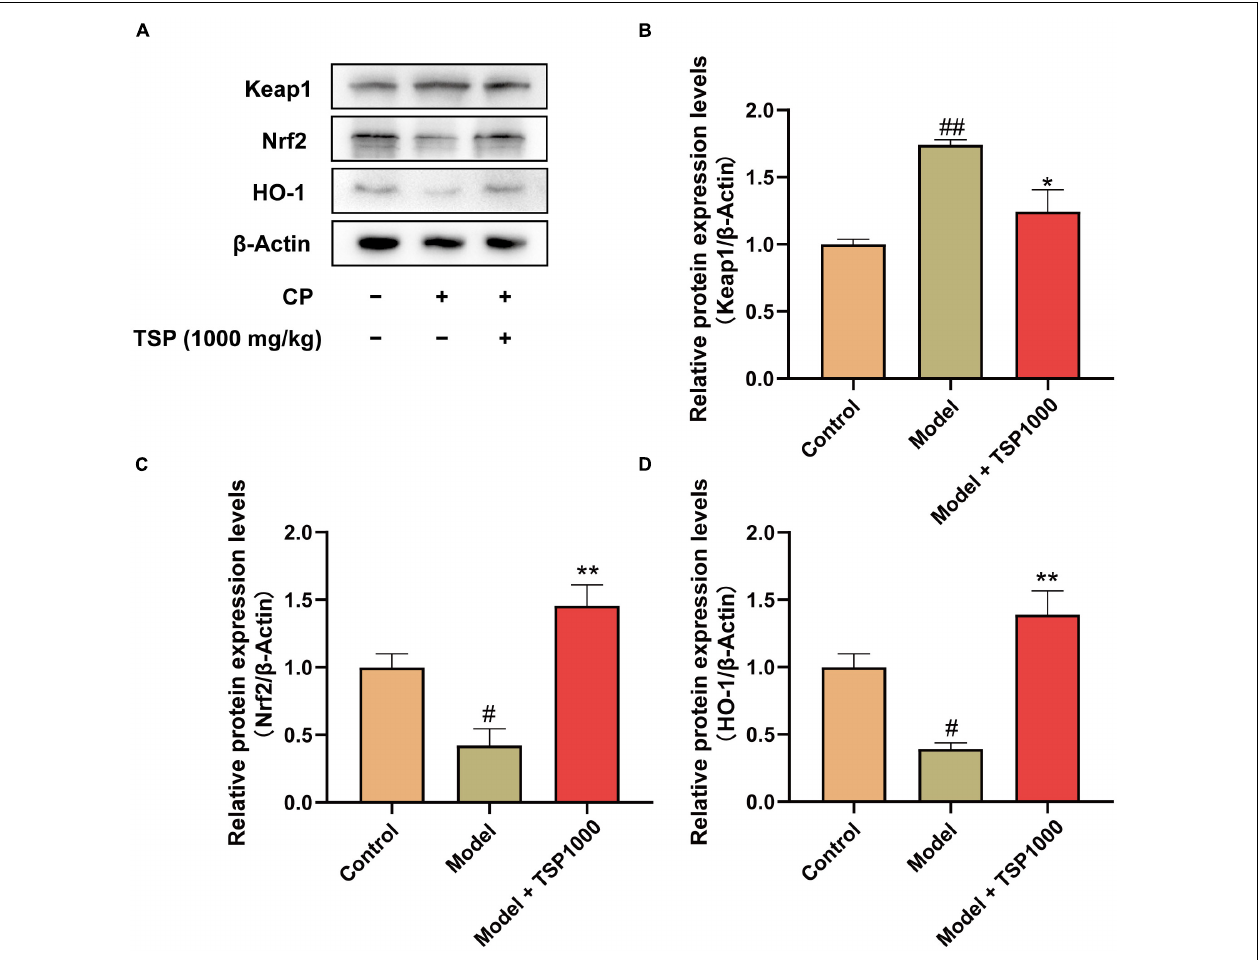
FIGURE 7 | The effects of TSP on the Nrf2/HO-1 signaling pathway. (A) The representative images of western blotting results. (B–D) Quantification of the protein expression of Keap1, Nrf2, and HO-1. All data were expressed as mean ± SEM ( n = 3). # P < 0.05, ## P < 0.01 vs. Control group; * P < 0.05, ** P < 0.01 vs. Model group.